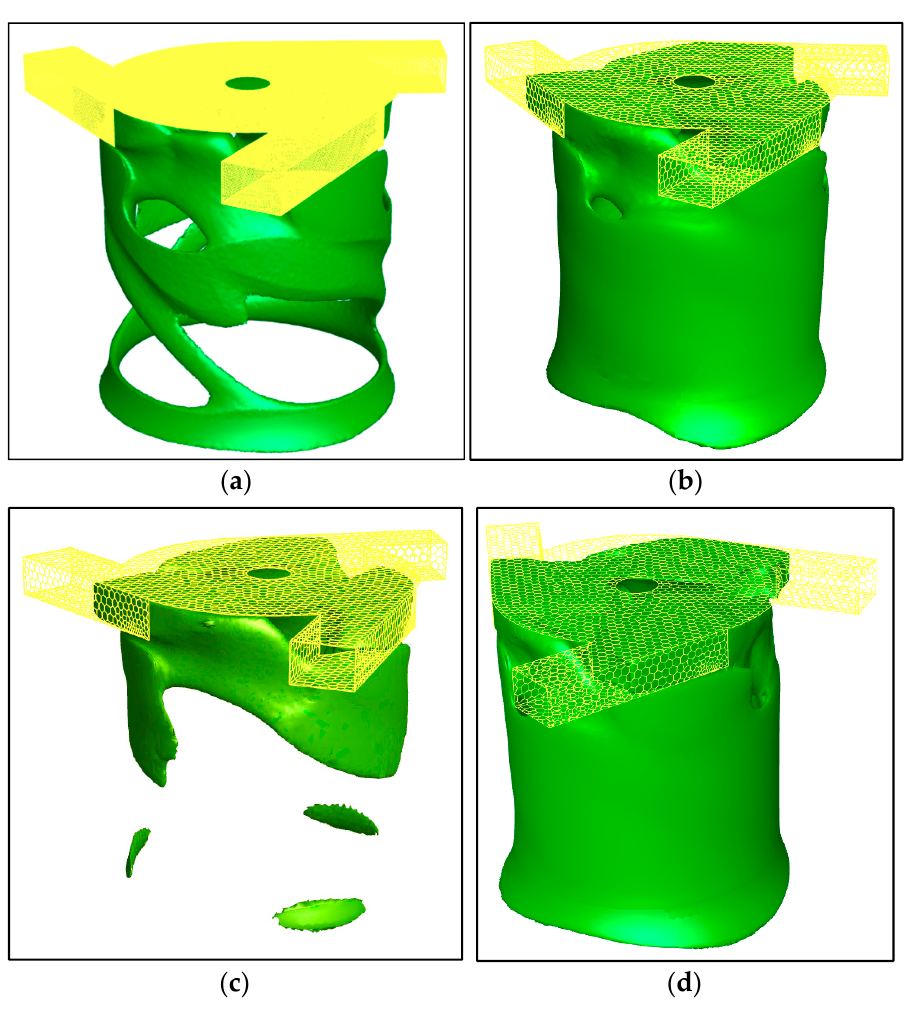
Figure 7. Mach number isosurface at M = 1 obtained for SVT with ( a ) Ar ; ( b ) air ; ( c ) He ; and ( d ) CO 2 .